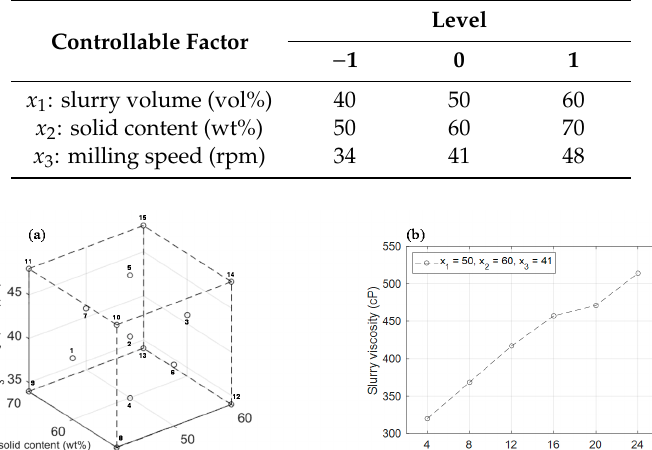
Table 1. Ranges and levels for the three controllable factors.